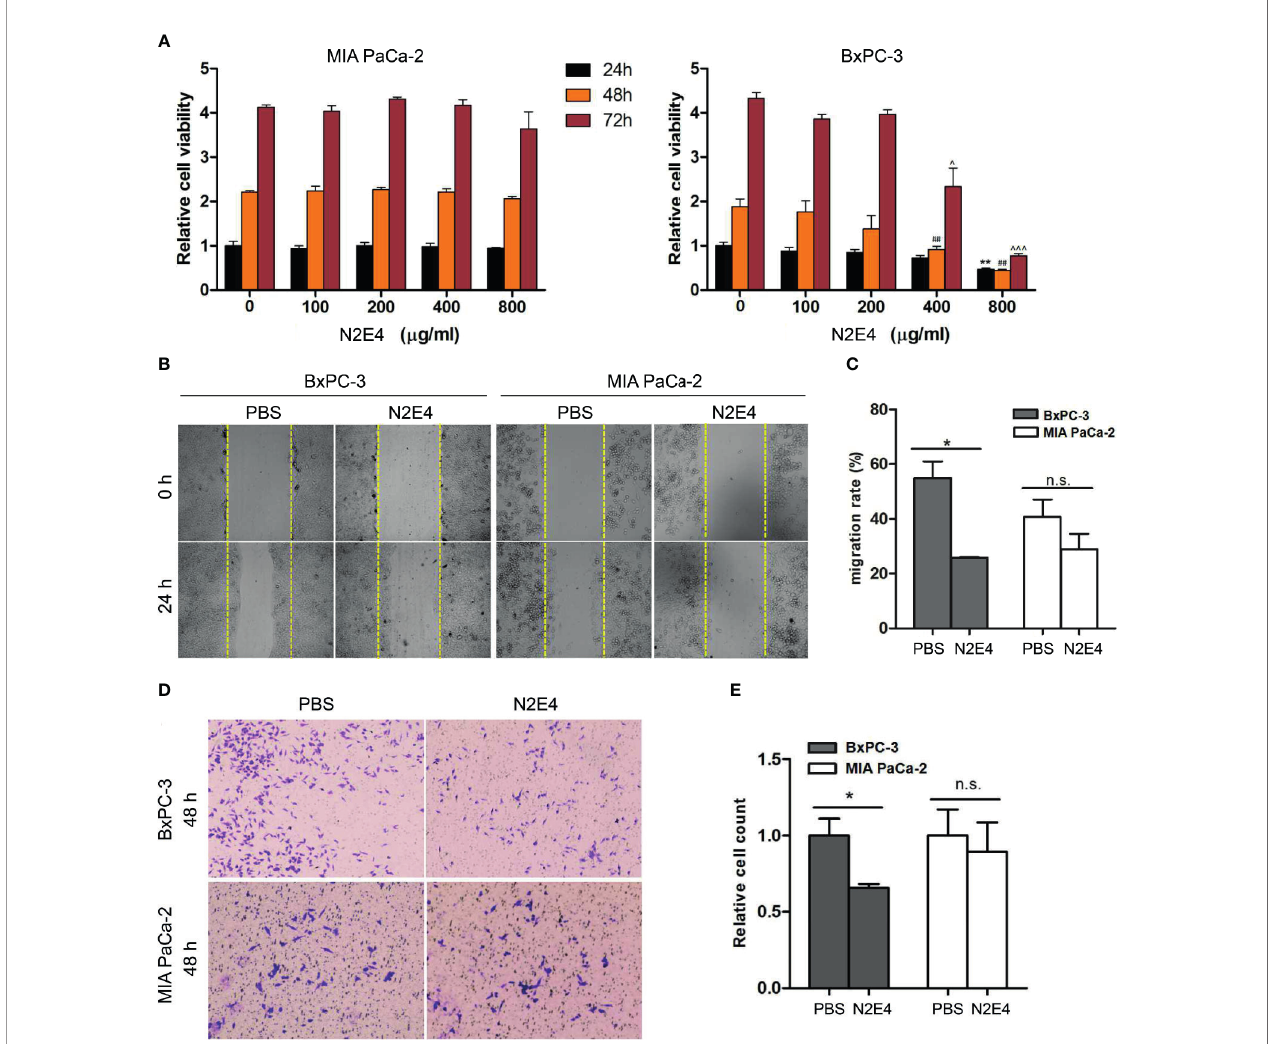
FIGURE 3 | Effect of N2E4 on cell viability, proliferation, invasion, and migration. (A) CCK8 assays were performed to compared cell viability against N2E4 in BxPC3 and MIA PaCa-2. Statistical analysis is based on the mean ± SD of at least three independent tests. ** P < 0.01 vs 0 m g/ml for 24 h group; ## P < 0.01 vs 0 m g/ml for 48 h group; ^ P < 0.05, ^^^ P < 0.001 vs 0 m g/ml for 72 h group. (B) Scratch assays veri fi ed the decrease of migration in BxPC-3 cells after the treatment of N2E4. (C) Statistical results were obtained as described above. (D) Matrigel-coated assays displayed that N2E4 decreased cell invasion ability in BxPC3. (E) Statistical results were obtained as described above. * P < 0.05; ** P < 0.01; n.s., no signi fi